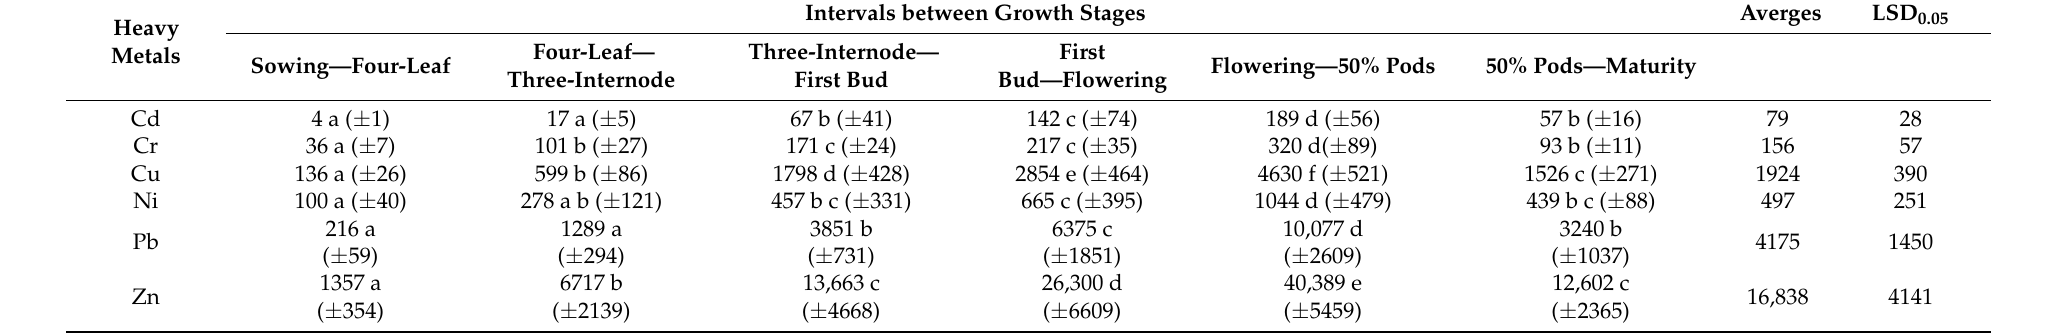
Table 7. HMD up by entire pea plants in successive growth stages and their averages, mg · ha − 1 (mean values ± SD of two cultivars and two successive years with three repetitions each).